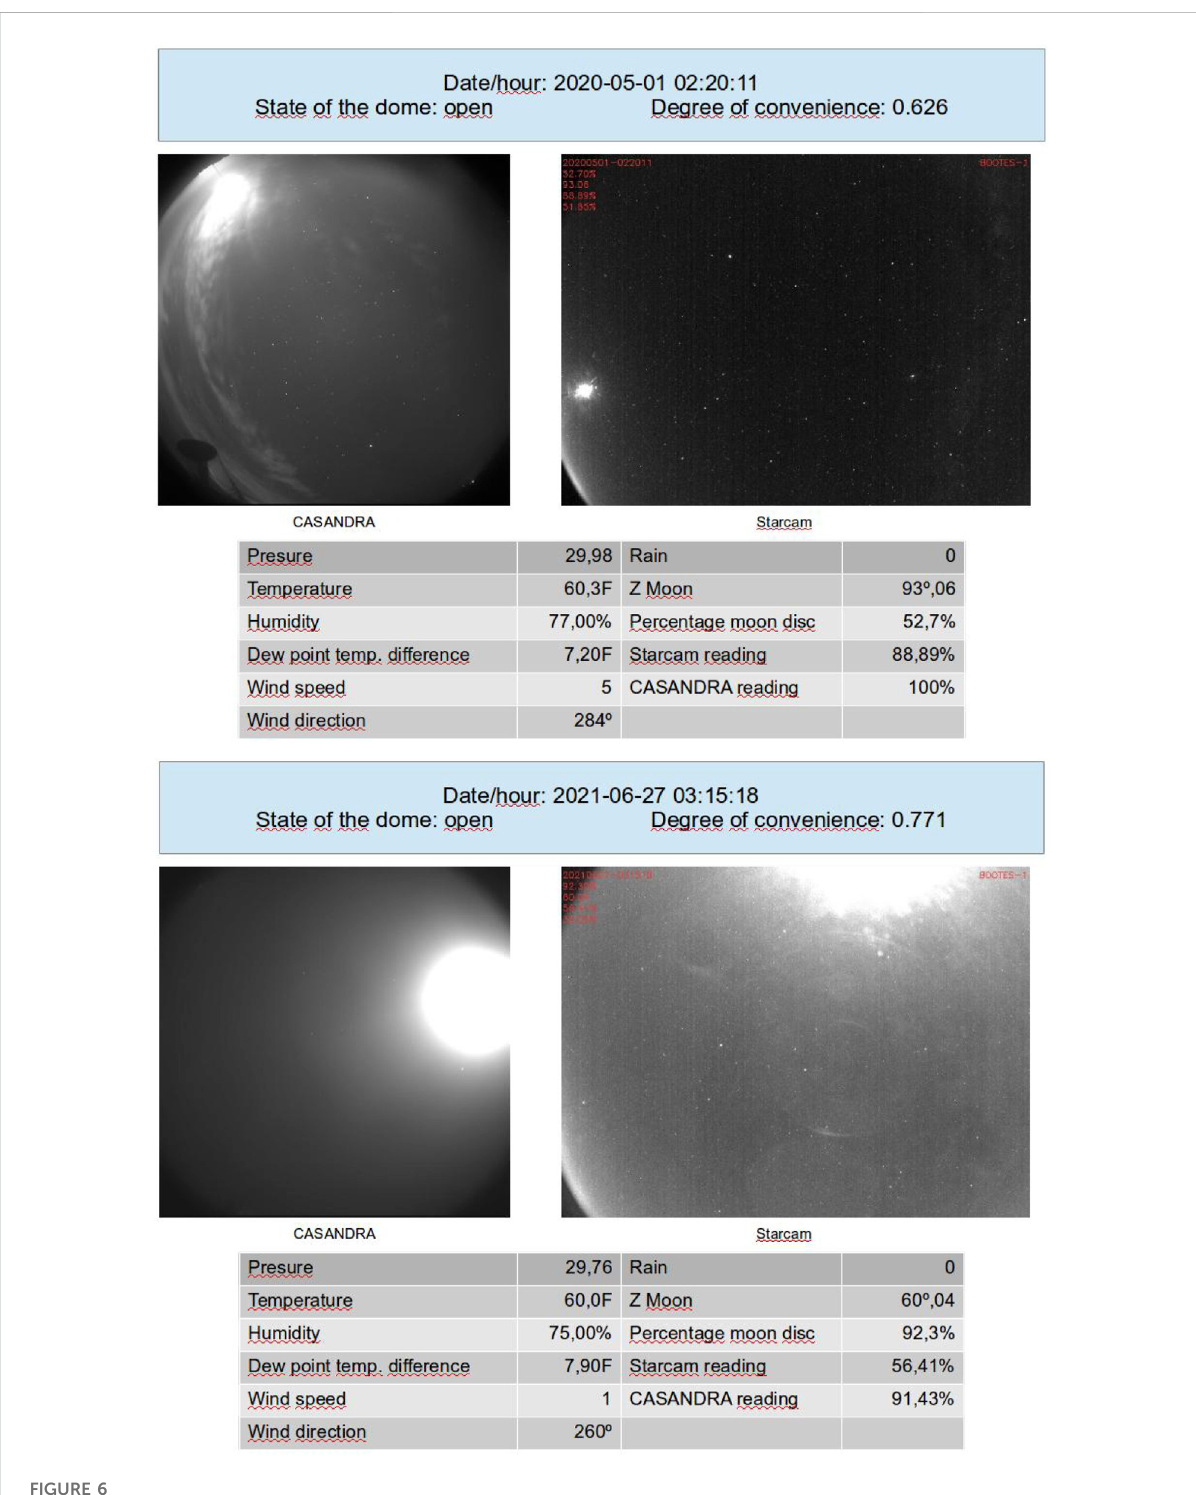
FIGURE 6 Degree of suitability indicates open dome, and the dome was